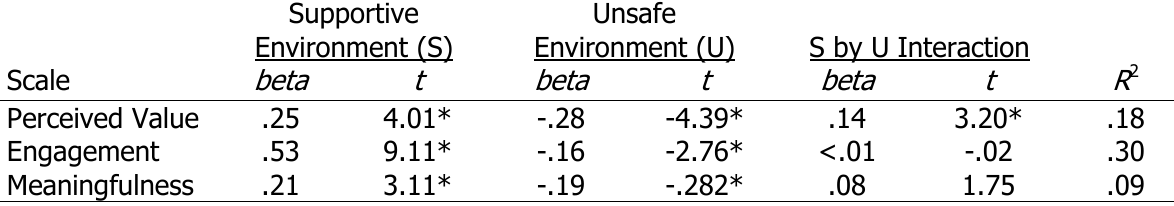
Regression of Monitoring Scales on Supportive Environment and Unsafe